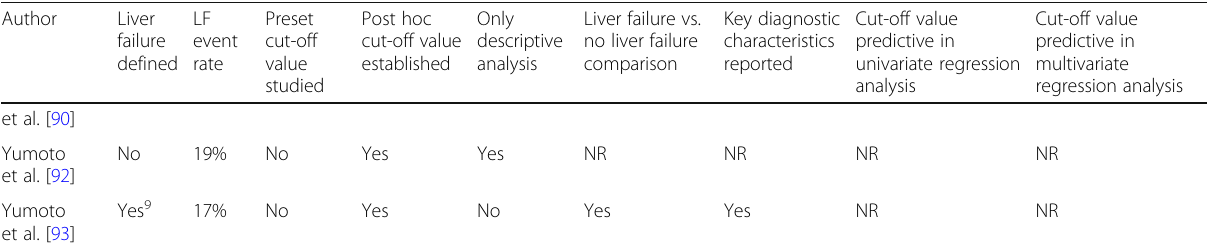
Table 3 Overview of the studies reporting on the correlation between a preoperative nuclear imaging examination and the postoperative outcome liver failure